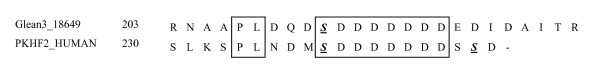
Alignment of [Glean3:18649] (Similar to pleckstrin homology domain-containing protein) phosphopeptide to its human counterpart. Phosphoserine 239 [39,47] of the human pleckstrin homology domain-containing family F member 2 protein is also phosphorylated in the homologous sea urchin protein. The phosphorylated serine 248 of human PKHF2 [47] is not conserved in the sea urchin protein.